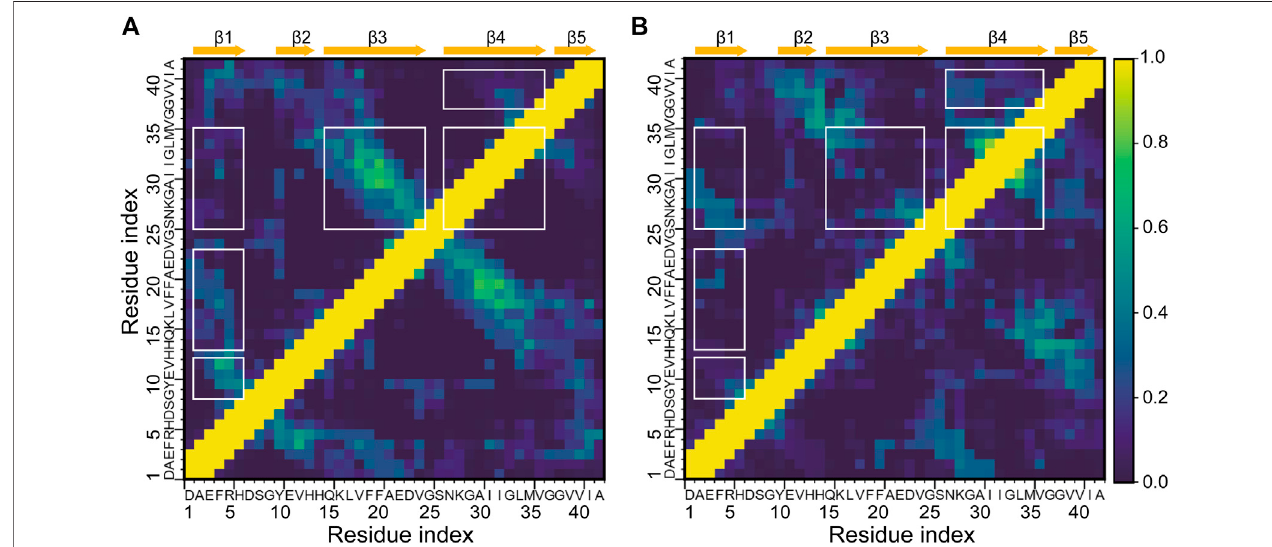
FIGURE 4 | Intrapeptide interaction maps of the A β 42 molecule (A) in the absence and (B) in the presence of HSA. Contact probabilities are displayed in a color scale from navy to yellow. Submatrices with distinct changes upon binding to HSA are highlighted by boxes in white.